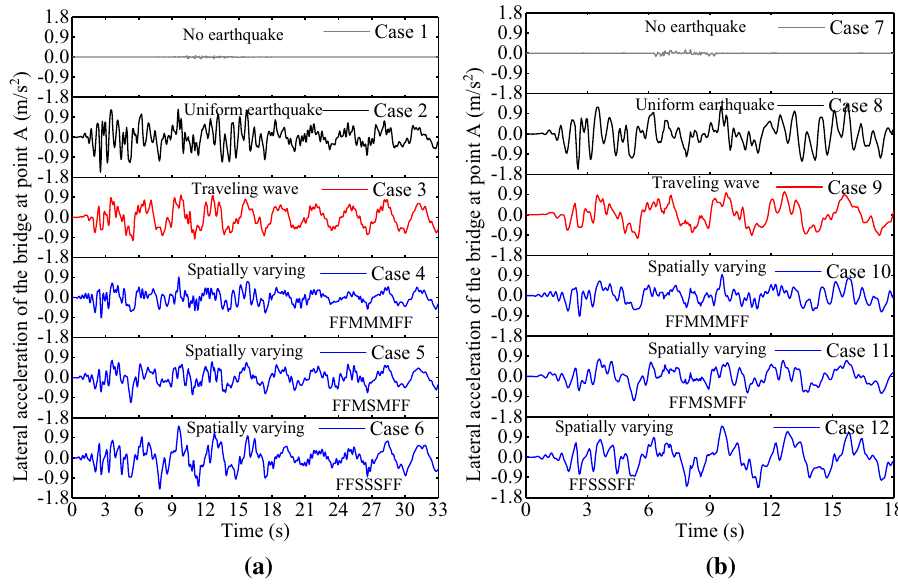
Fig. 13 Time histories of the lateral acceleration of the bridge at point A: a cases 1–6; b cases 7–12